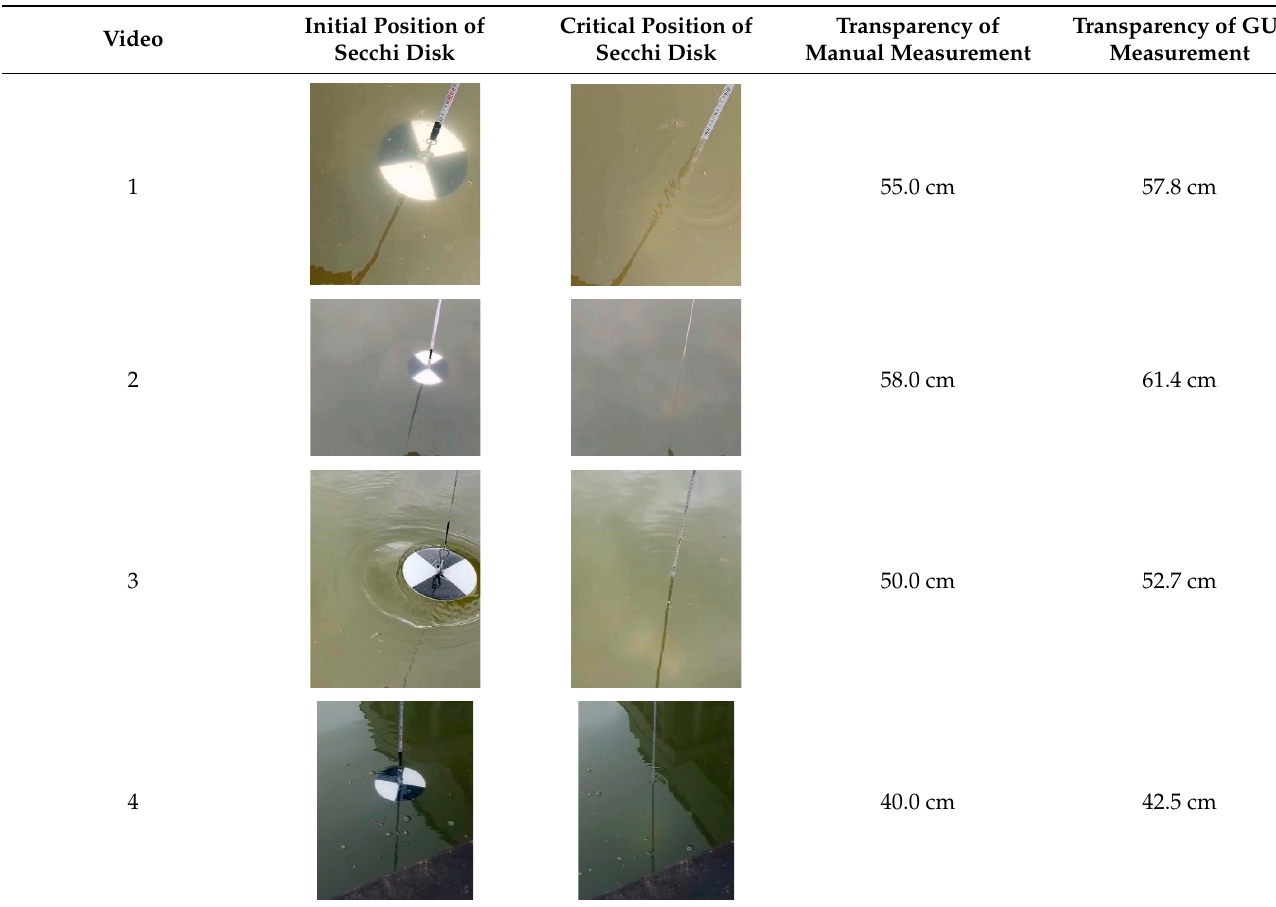
Table 7. Overall test results of the algorithm.